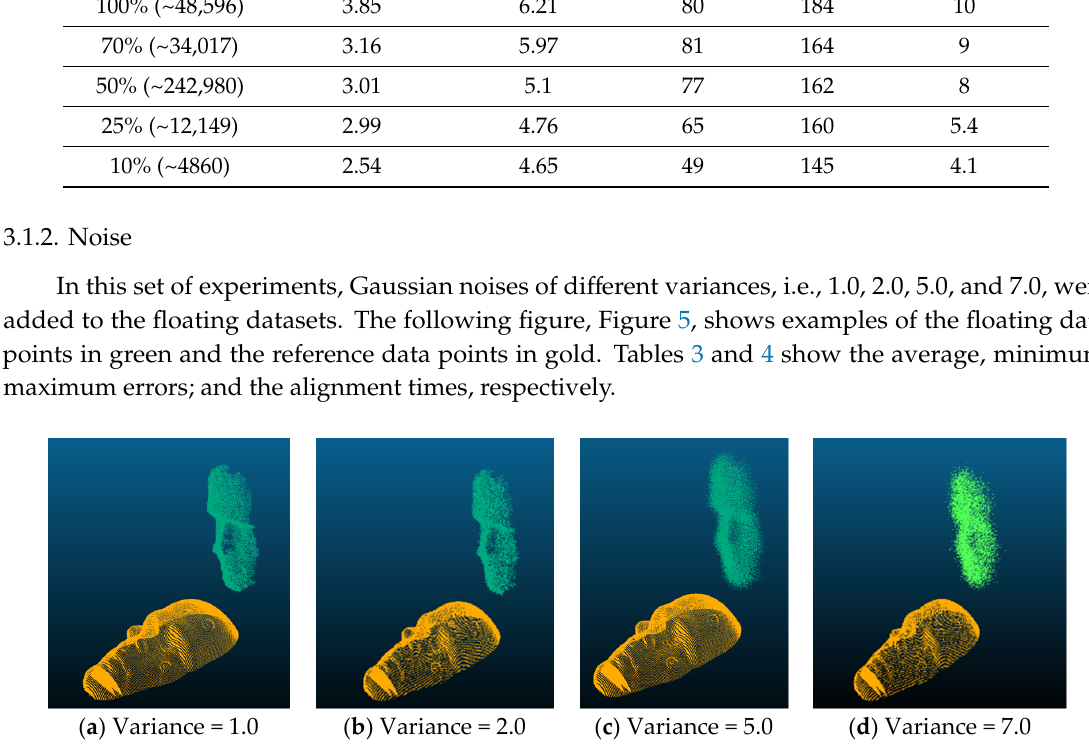
Figure 5. Examples of floating (green) with Gaussian noises and reference points (gold) used in the experiments. Table 3. The Average, Minimum and Maximum of Reference Points’ Alignment Errors.